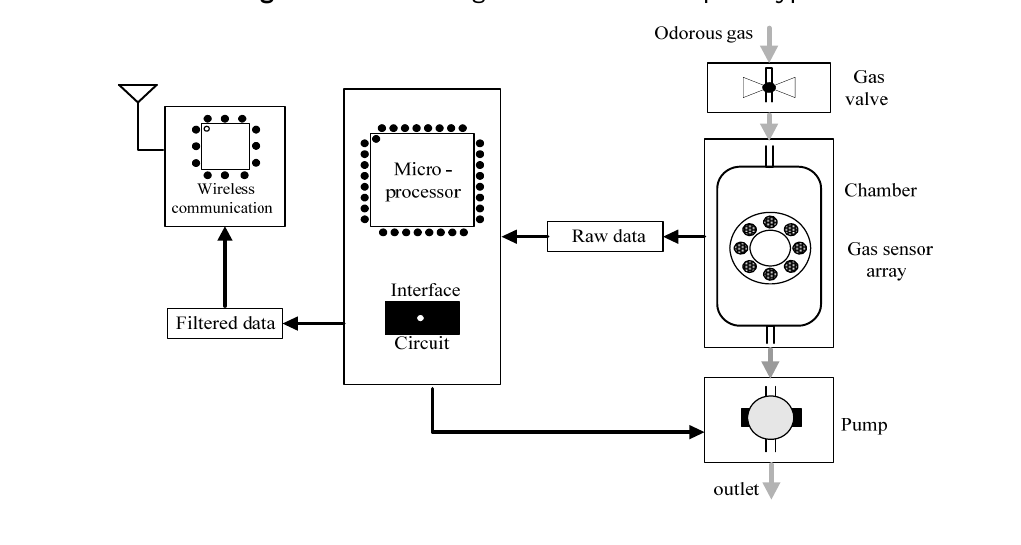
Figure 1. Block diagram of the e-nose prototype.